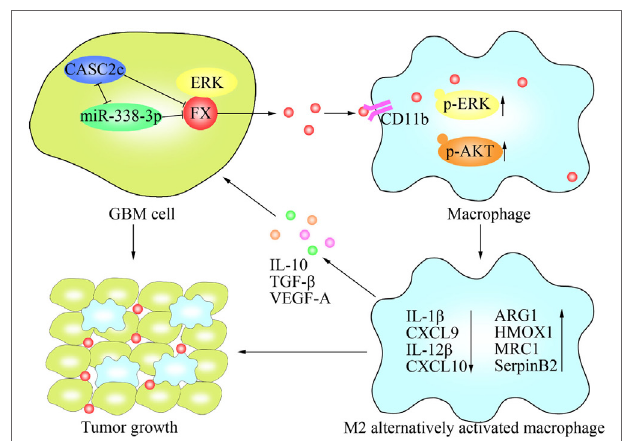
FigUre 8 | Schematic model of the molecular mechanisms representing the function of factor X (FX) in glioblastoma multiforme (GBM) tumor growth. FX secreted by GBM cells to the tumor microenvironment and recruited macrophages to the tumor via interactions with CD11b on the surfaces of macrophages. FX phosphorylated and activated extracellular signal-related kinase (ERK)1/2 and AKT in macrophages, leading to M2 subtype macrophage polarization, which facilitated GBM tumor growth. In GBM cells, miR-338-3p and lncRNA CASC2c inhibited the expression of FX. lncRNA CASC2c also interacted with miR-338-3p and reciprocally repressed it. FX interacted with ERK1/2 and decreased